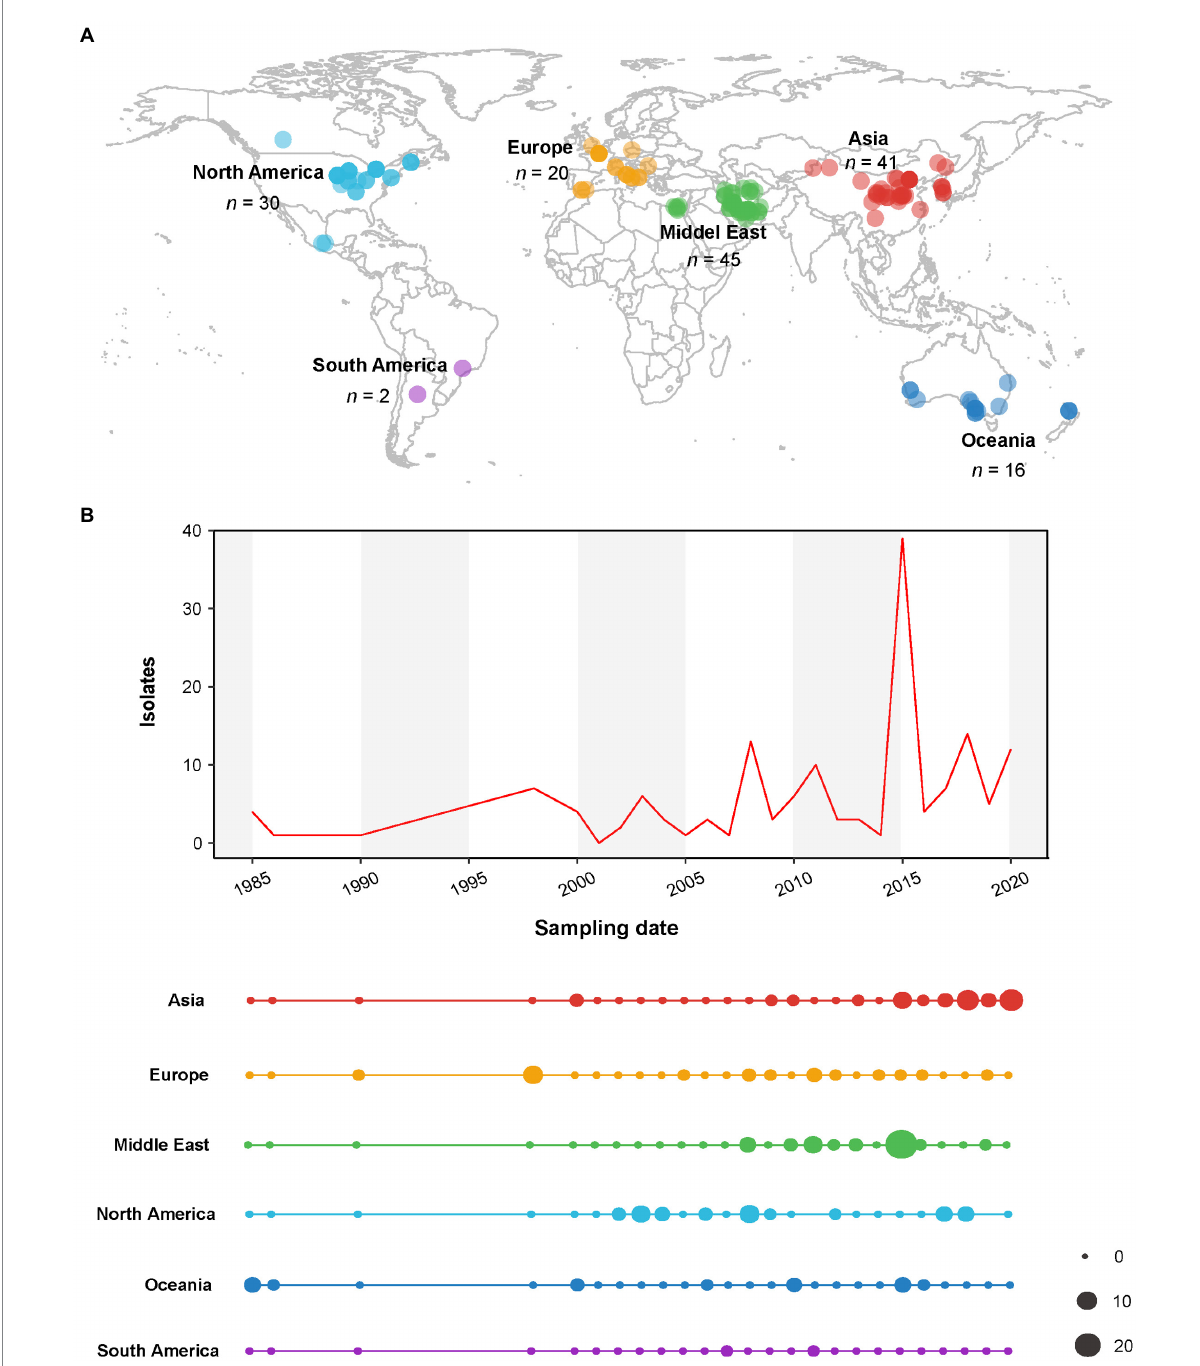
FIGURE 1 Spatial and temporal distribution of alfalfa mosaic virus (AMV) isolates used in this study. (A) Map illustrating geographic locations of AMV. (B) The total sample size and the distribution across the geographic locations over time (years). The dot sizes are proportional to the sample